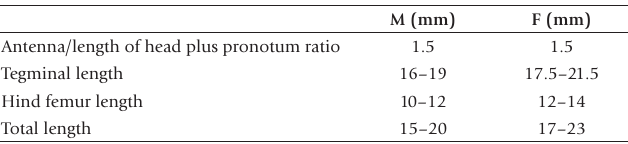
Table 8. Morphometric measurements of Gymnobothrus longicomis ephippinotus